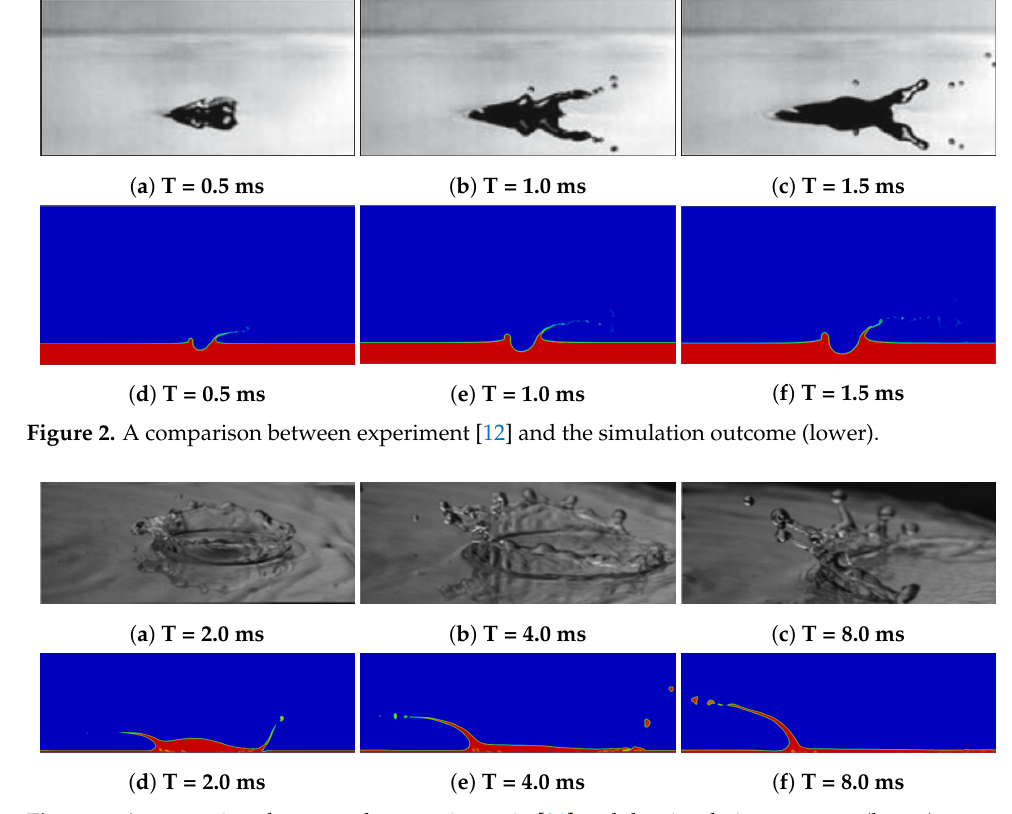
Figure 3. A comparison between the experiment in [21] and the simulation outcome (lower).